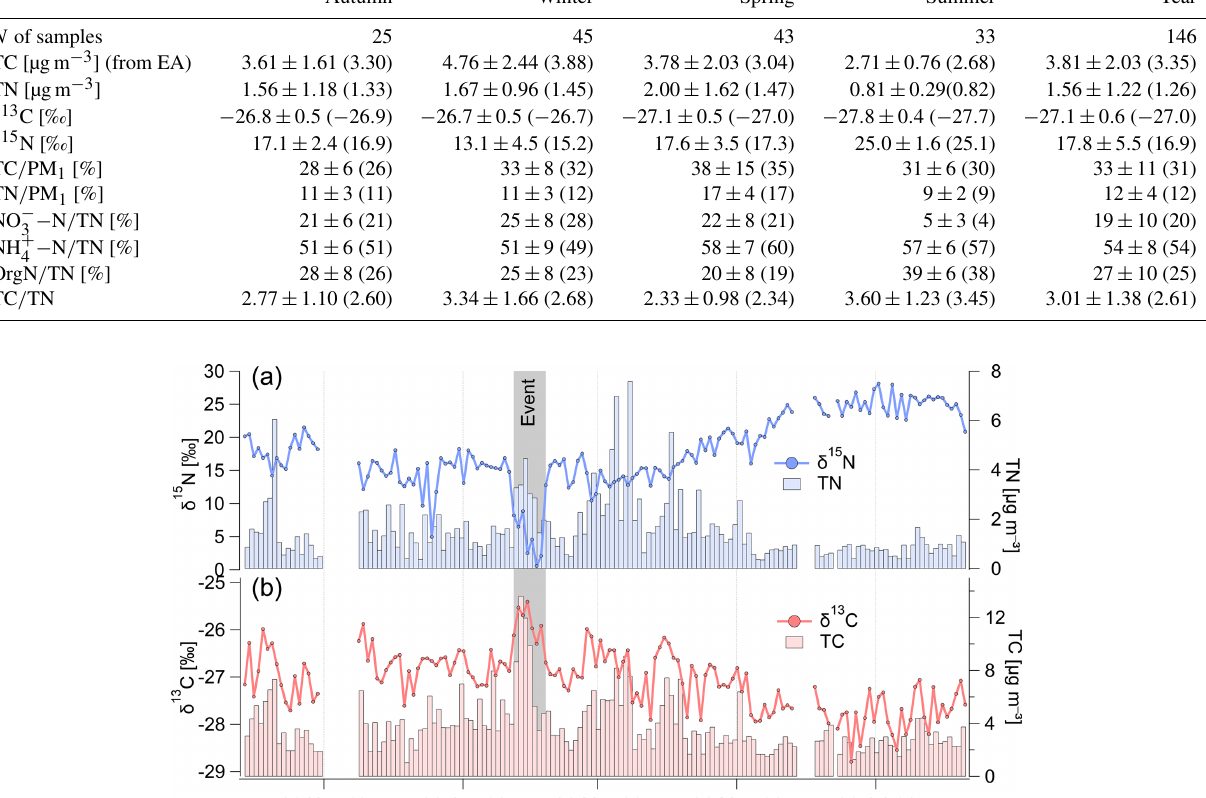
Table 1. Seasonal and entire campaign averages ± standard deviations (medians in brackets) of different variables. Autumn